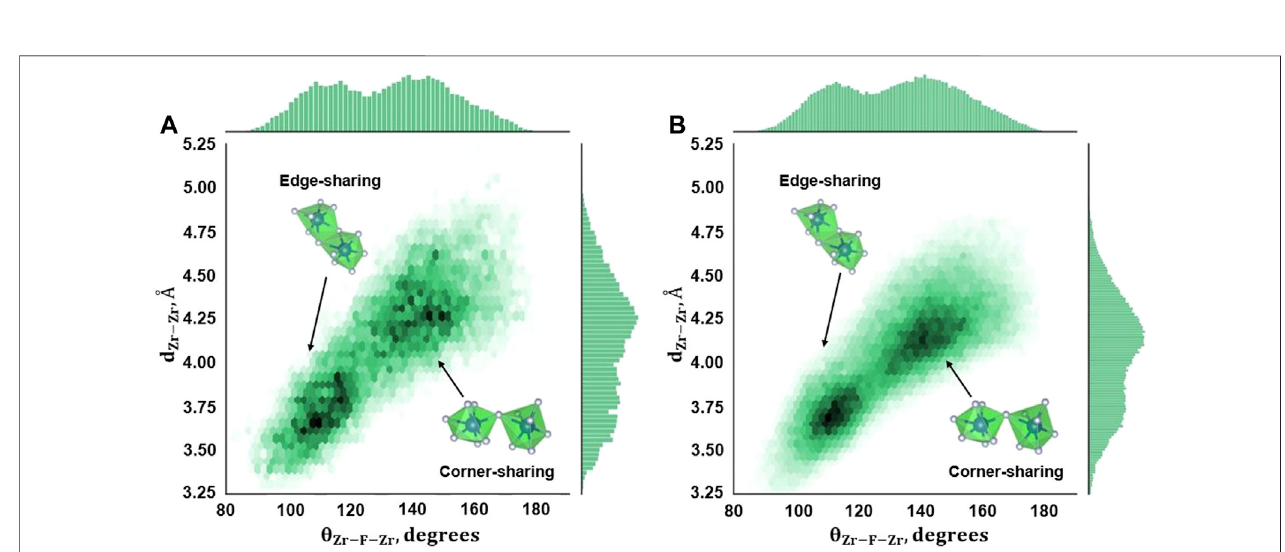
FIGURE 5 | Zr – F – Zr Angle distribution from AIMD calculations for (A) Composition B, 727 ° C, and (B) Composition C, 700 ° C.